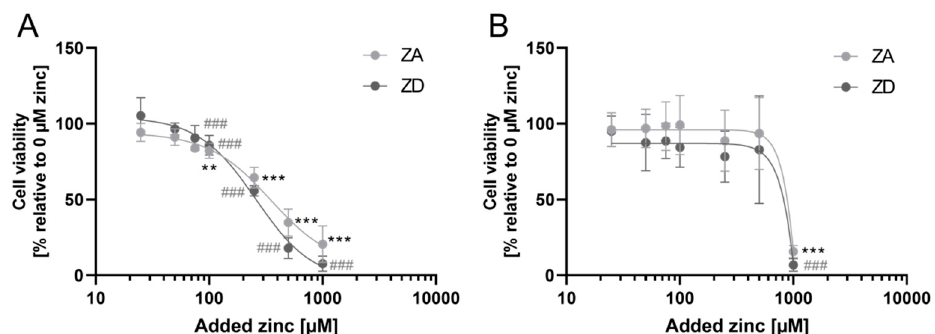
Figure 2 . Impact of zinc deficiency on cellular zinc toxicity. HT-29-MTX cells were cultivated for 7 days ( A ) or 14 days ( B ), respectively, in zinc-deficient (ZD) or -adequate (ZA) medium. Cells were treated with different zinc concentrations for 24 h and metabolic activity was measured with MTT. Data are presented as means ± SD of three independent experiments. Significant differences to 0 µM zinc are indicated (** p < 0.01; *** p < 0.001; , ### p < 0.001; one-way ANOVA with Dunnett’s multiple comparison test). Parameters of non-linear regression summarized in Supplementary Table S1.